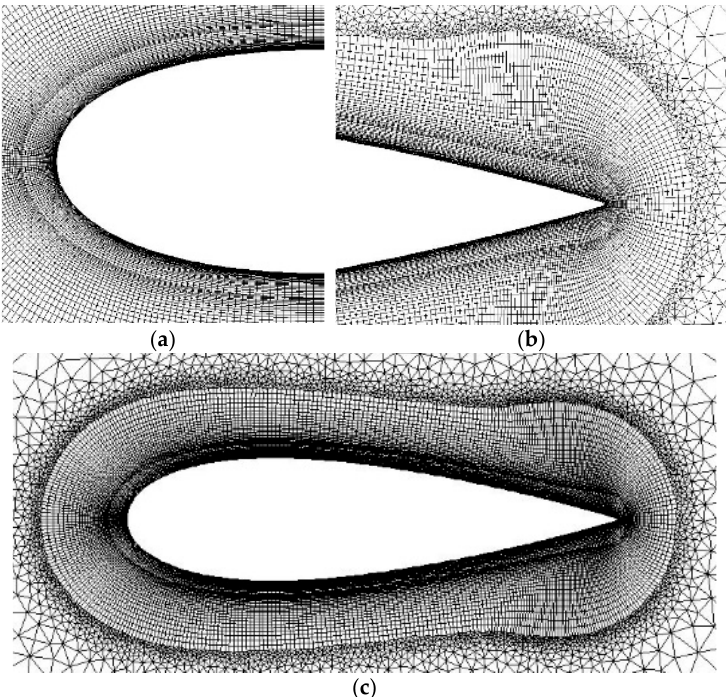
Figure 2. Near blade mesh at ( a ) the leading edge, ( b ) the trailing edge and ( c ) full blade mesh visualization.